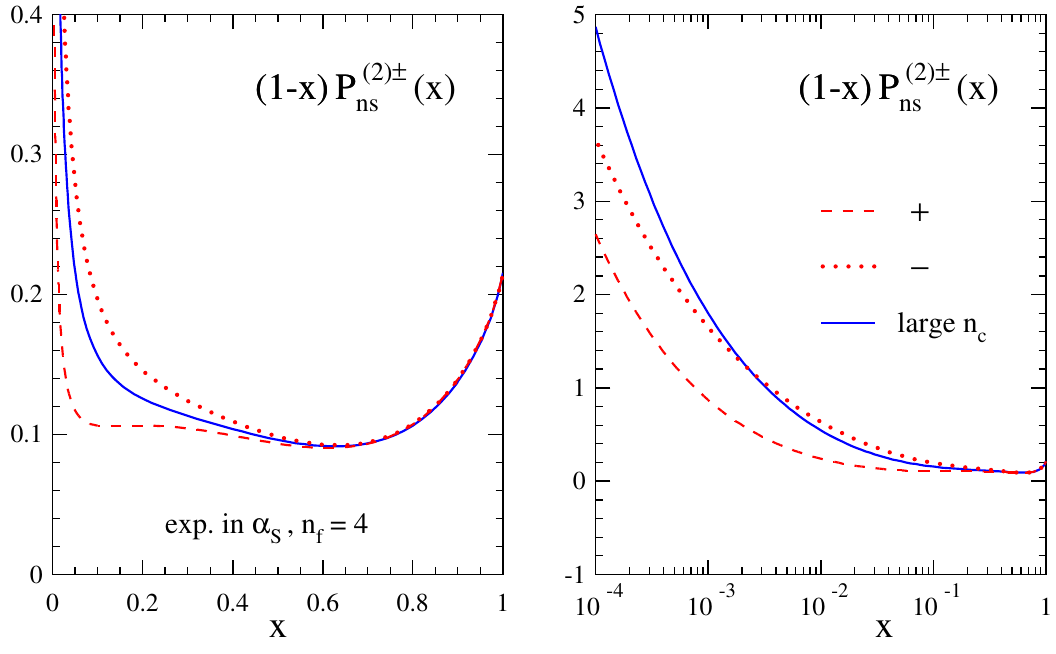
Figure 7 . The three-loop splitting functions P (2) (cid:6) ns ( x ) and their large- n c limit for QCD with four (cid:13)avours.